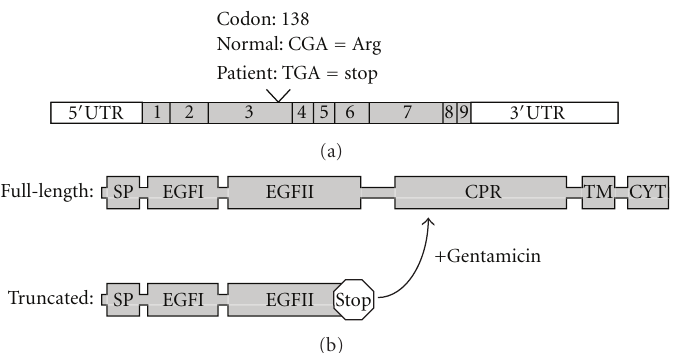
Figure 1: Schematic depiction of the EpCAM mutation and its consequences. (a) EpCAM mRNA (top): nonsense mutation seen in this patient located in exon 3, codon 138. Shaded boxes represent nine exons with surrounding untranslated (UTR) regions. (b) Full-length EpCAM protein (top) depicting domains: signal peptide (SP), EGF-like (EGF-I and EGF-II), cysteine poor region (CPR), transmembrane domain (TM), and cytoplasmic (CYT) domains, and truncated EpCAM (below) resulting from nonsense mutation and shift towards full length with gentamicin treatment.